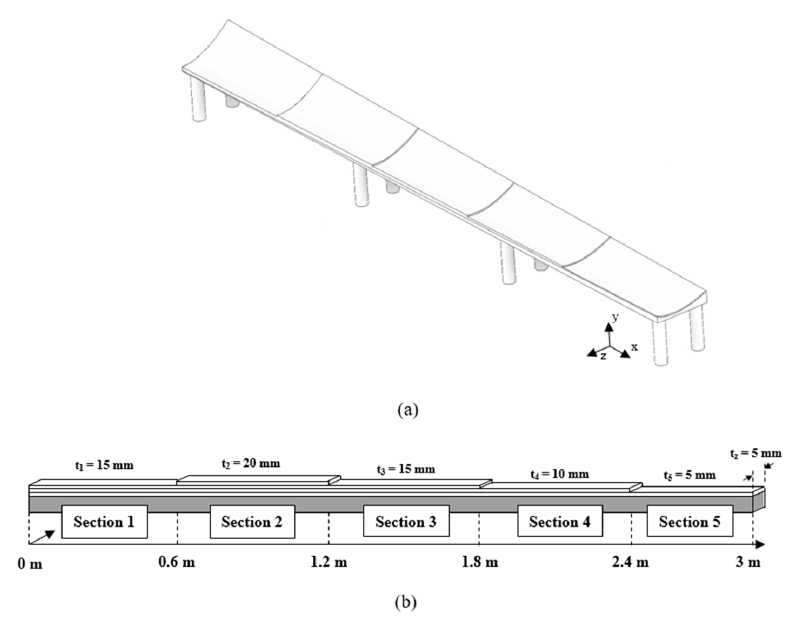
Figure 2. Spar-cap modeling for 20 kW wind turbine: ( a ) full-scale geometry model of heat transfer simulation; ( b ) schematic diagram of spar-cap modeling that defines dimensions and sections.